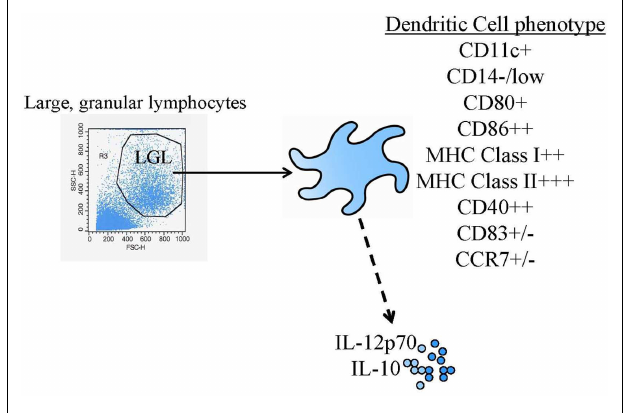
FIGURE 1 | Common DC vaccine phenotypic and functional assessments .The diagram shows the most common identity (flow cytometric phenotyping) and potency (cytokine production) tests performed.